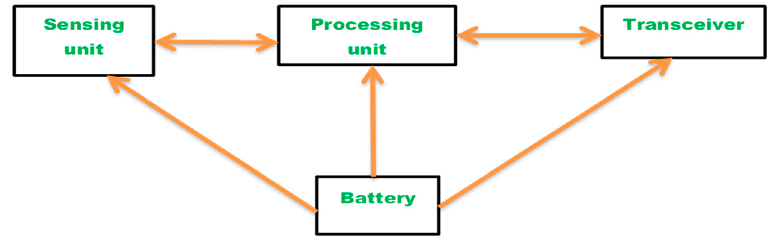
Figure 1. The inner architecture of a sensor node.